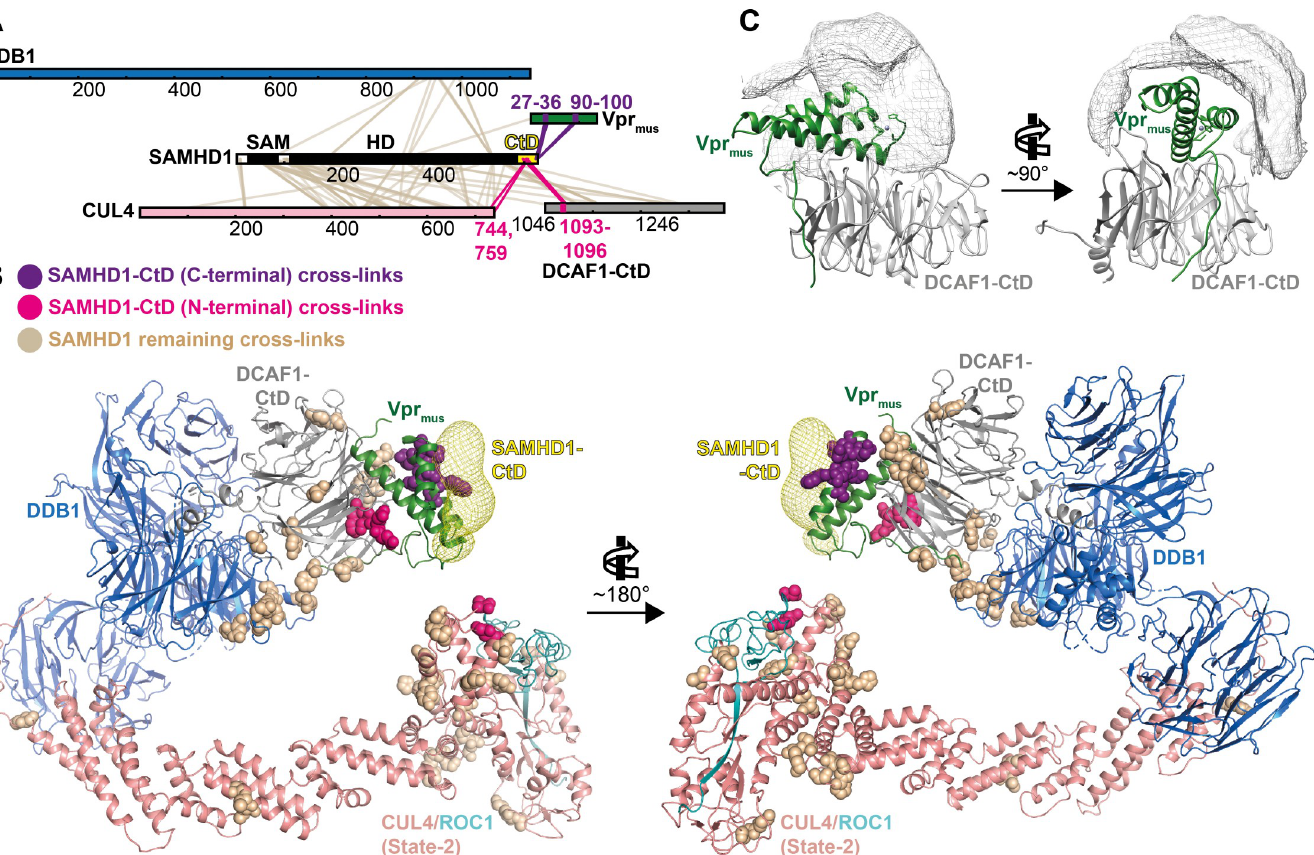
Fig 5. Cross-linking mass spectrometry (CLMS) analysis of CRL4 DCAF1-CtD / Vpr mus /SAMHD1. ( A ) Schematic representation of sulfo-SDA cross-links between CRL4 DCAF1 /Vpr mus and SAMHD1, identified by CLMS. Proteins are colour-coded as in Figs 3 and 4, and SAMHD1 black/white. SAMHD1-CtD is highlighted in yellow. Crosslinks to the N-terminal SAMHD1 globular SAM and HD domains are coloured light brown, while cross-links to the N-terminal half of SAMHD1-CtD are highlighted in pink and cross-links to the C-terminal end of SAMHD1-CtD are coloured purple. ( B ) Sulfo-SDA cross-links from A , in the same colour scheme, mapped on the molecular model of CRL4-NEDD8 DCAF1-CtD /Vpr mus /SAMHD1 (state-2), obtained from cryo-EM analysis (Fig 3). SAMHD1-CtD density from the CRL4-NEDD8 DCAF1-CtD /Vpr mus /SAMHD1 (core) cryo-EM analysis (Fig 4) is shown as yellow mesh. ( C ) The accessible interaction space of SAMHD1-CtD, calculated by the DisVis server [61], consistent with at least 14 of 26 observed cross-links, is visualised as grey mesh. DCAF1-CtD and Vpr mus are oriented and coloured as in Fig